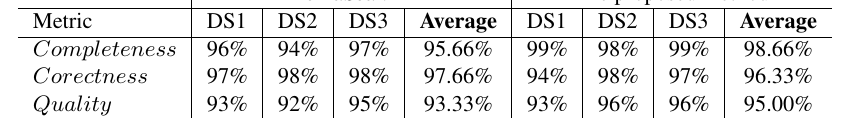
Table 2: Quantitative evaluation of the proposed building-extraction method in comparison with TerraScan R (cid:13)